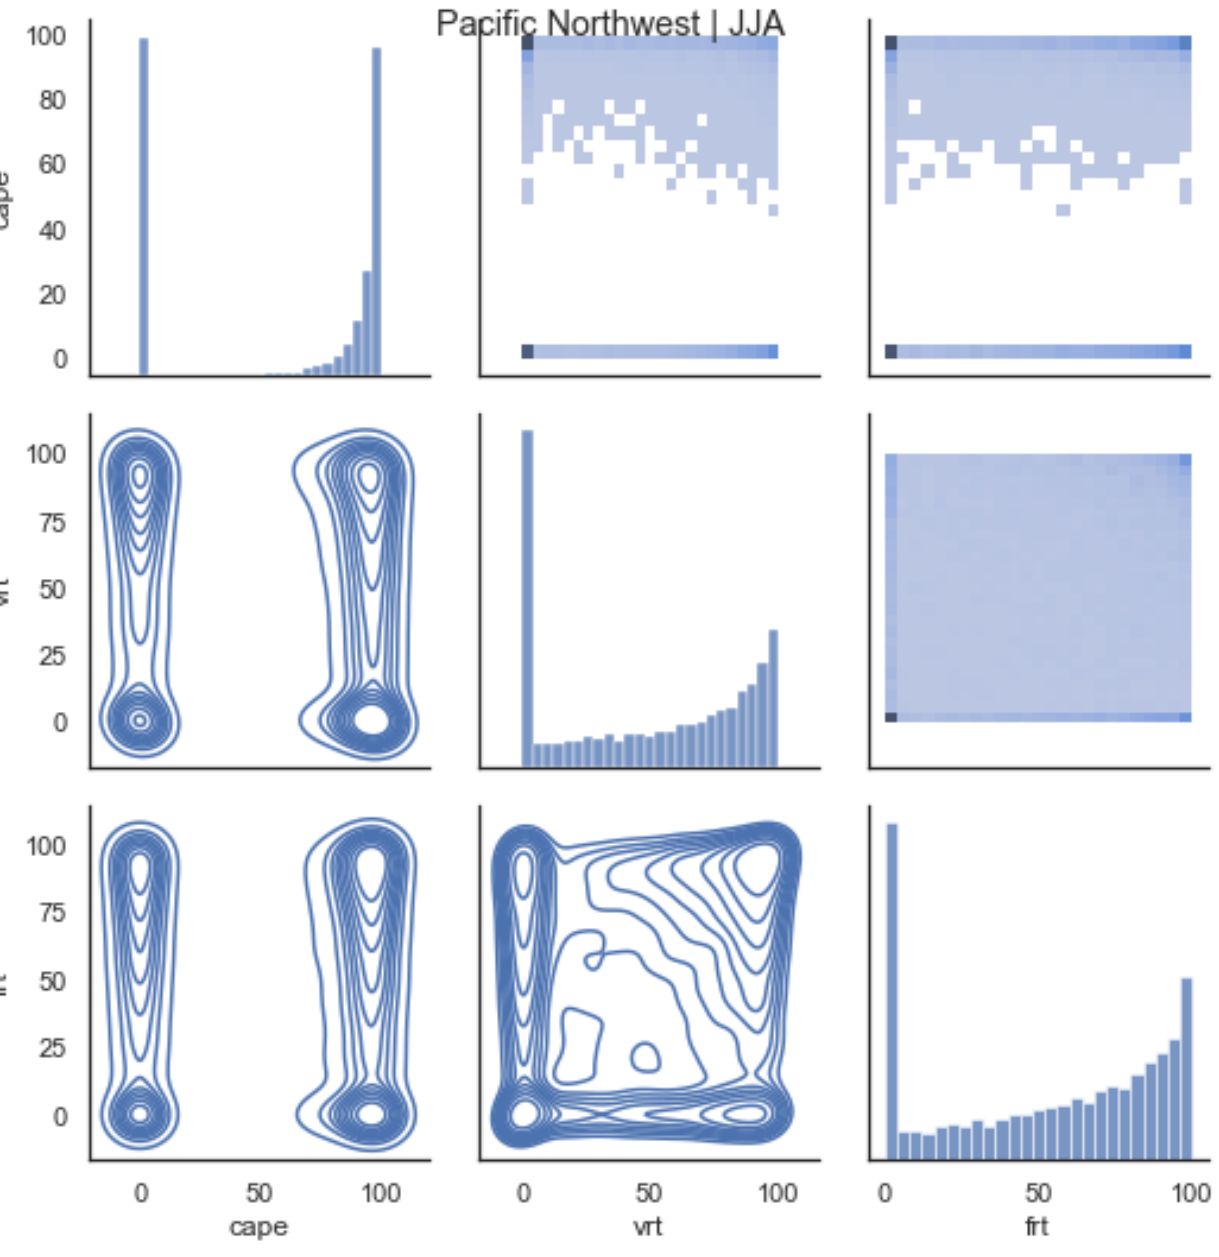
Figure 5. The plots along the diagonal are the univariate distribution of each of the three processes (Convection, Vorticity, and Frontal). The x -axis is the rank of the process and the y -axis is a density function over all events in the named region and season. The lower triangular panels show a kernel density plot of the two processes indicated on the corresponding x and y axis labels. The upper triangular panels show the same data as a bivariate